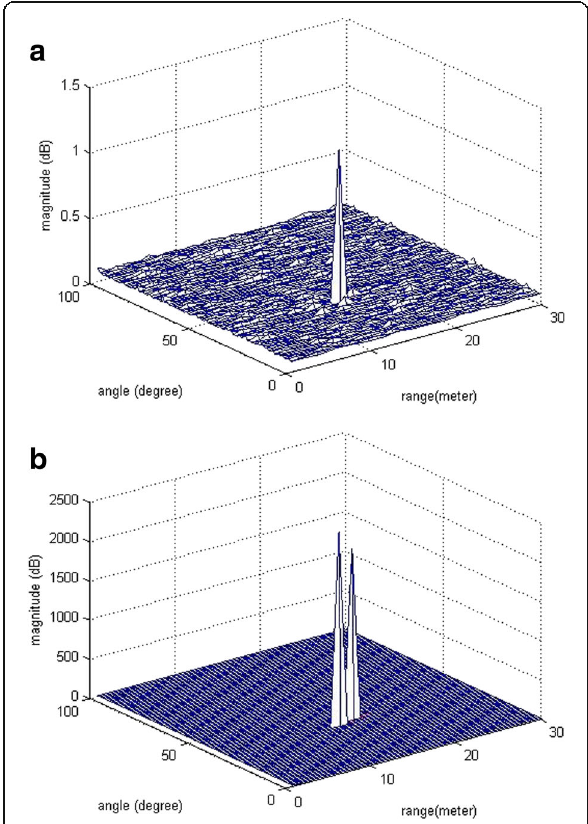
Fig. 2 Comparison of the angular spectrum. a FrFT-MUSIC. b FrFT-SPICE